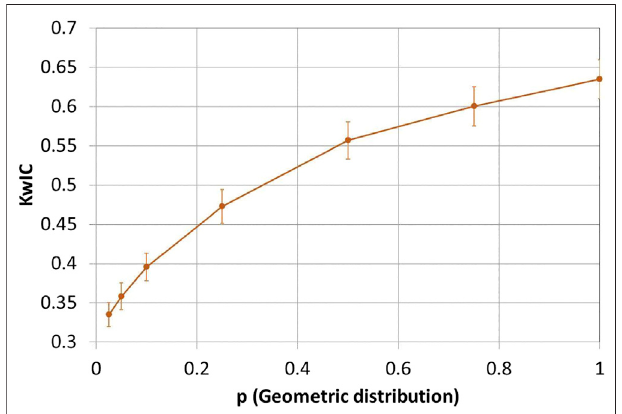
FIGURE 6 | KwIC scores for different probabilities of success. p is probability of success, which provides the term distance between the two simulated curators. p (cid:1) 1.0 is perfect agreement. KwIC averaged for 100 simulatedannotatedcorporaateach p .Barsshowstandarddeviationof the KwIC